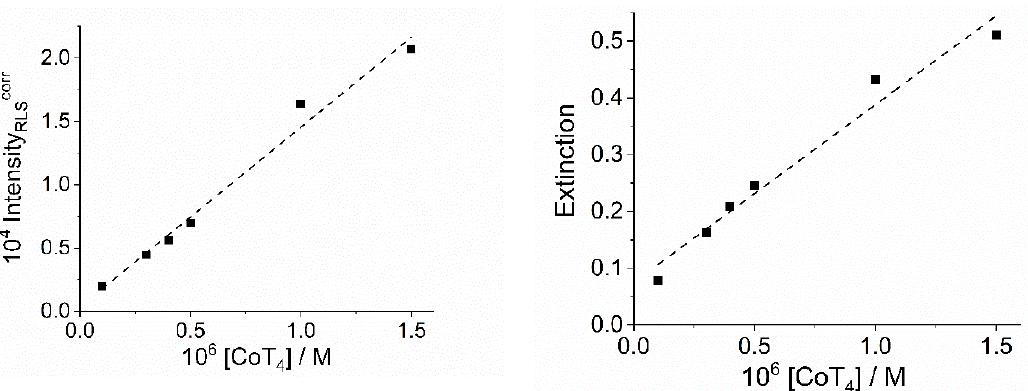
Figure 5. Intensity of RLS spectra corrected for extinction ( left ) and extinction of the samples at the end of the TPPS 4 aggregation process catalyzed by CoT 4 ( right ) as a function of the concentration of this metal derivative. (Experimental conditions: [TPPS 4 ] = 3 μ M; [HCl] = 0.00158 M, T = 298 K). The lines represent the linear best fits to the experimental data (I RLScorr = 10 4 × (0.035 ± 0.074) +10 4 × (1.419 ± 0.093) × [CoT 4 ]; Ext = (0.075 ± 0.022) + (0.313 ± 0.028) × [CoT 4 ]).